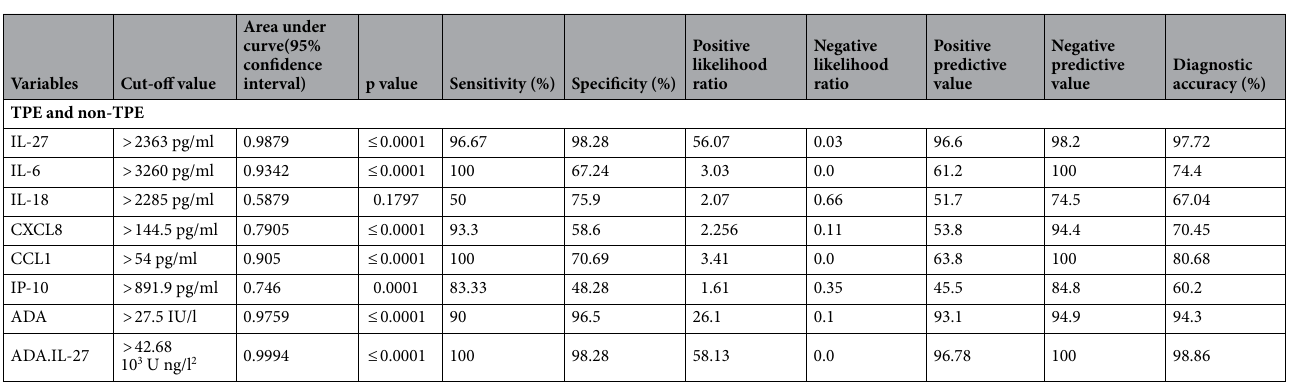
Table 4. The diagnostic accuracy of IL-6, IL-18, IL-27, CXCL8, CCL1, IP-10 and ADA in the differentiation of tuberculous from non-tuberculous effusions (Malignant, empyema and parapneumonic effusions). ADA adenosine deaminase, IL interleukin, CXCL C-X-C motif chemokine ligand, CCL C–C motif chemokine ligand, IP-10 interferon gamma-induced protein 10 or